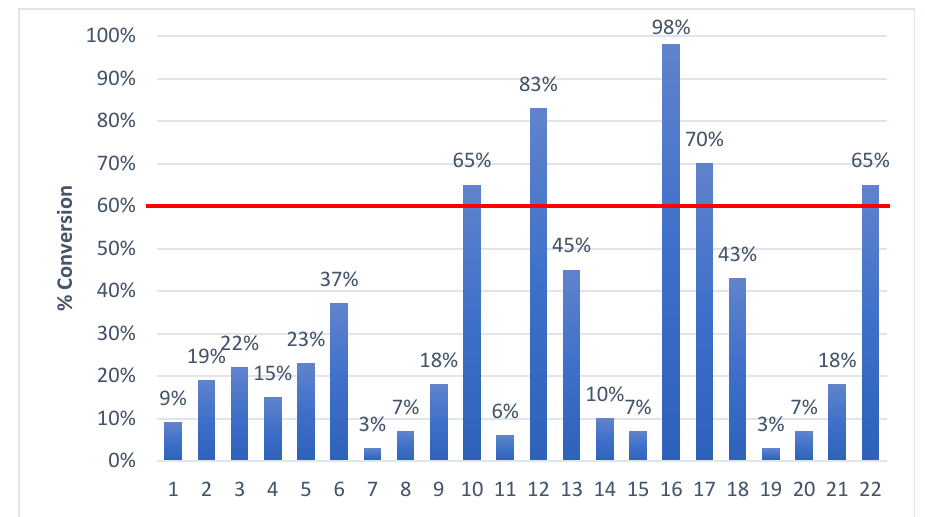
Figure 2. Summary of the conversion rate obtained with each catalyst.